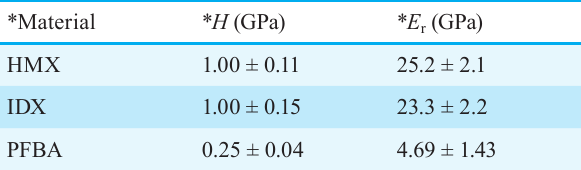
Table 6 Mechanical properties for HMX (explosive) and two “mock” APIs ( n ~20 indentations × 10 crystals per material).